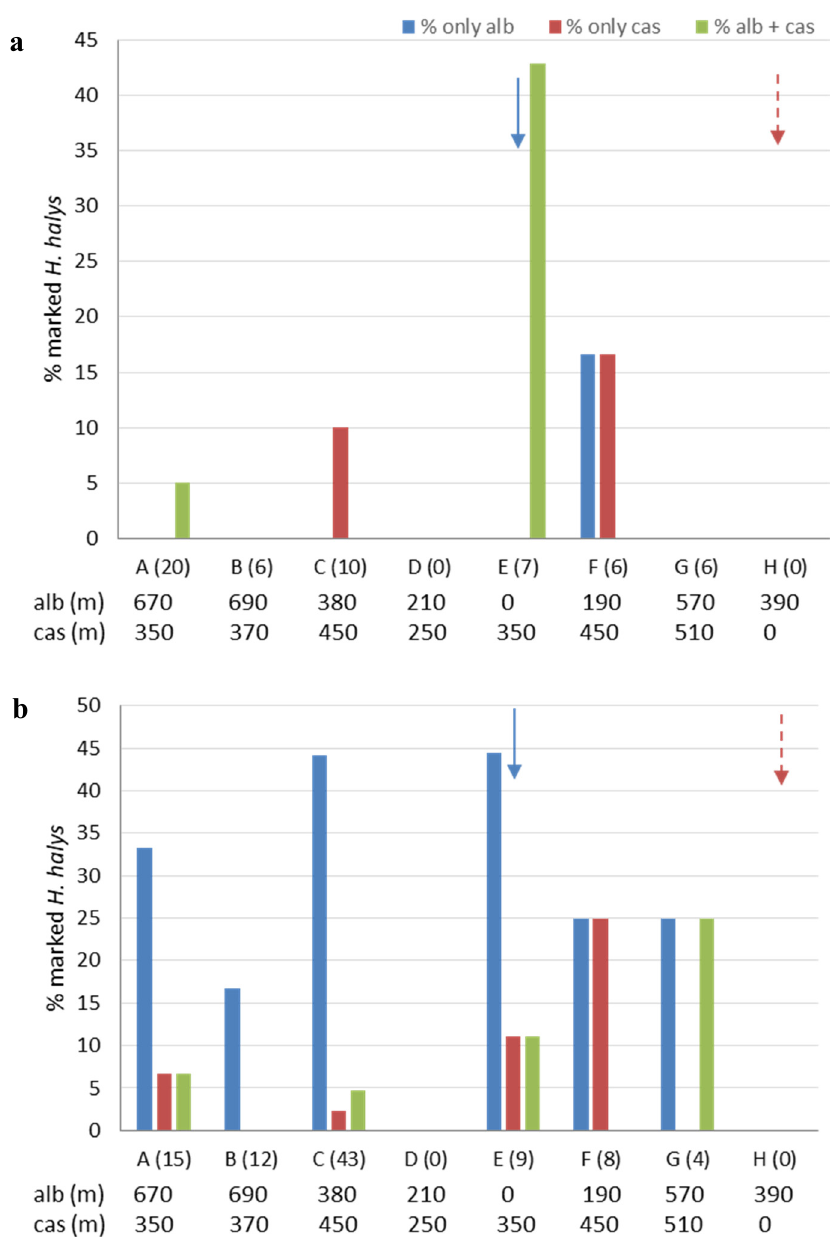
Figure 8. Total percentages of marked Halyomorpha halys adults collected in the sampling zones (A–H) of Area 4 from 19 April to 17 May ( a ) and from 18 May to 22 June ( b ). On the x-axes for each zone the total number of tested specimens is given in brackets. For each zone, the distance (meters) from the treatment site is also indicated either for albumin (“alb”) or casein (“cas”). Arrows designate the zones in which treatments with casein (dashed dark red arrow) and albumin (blue arrow) were applied.